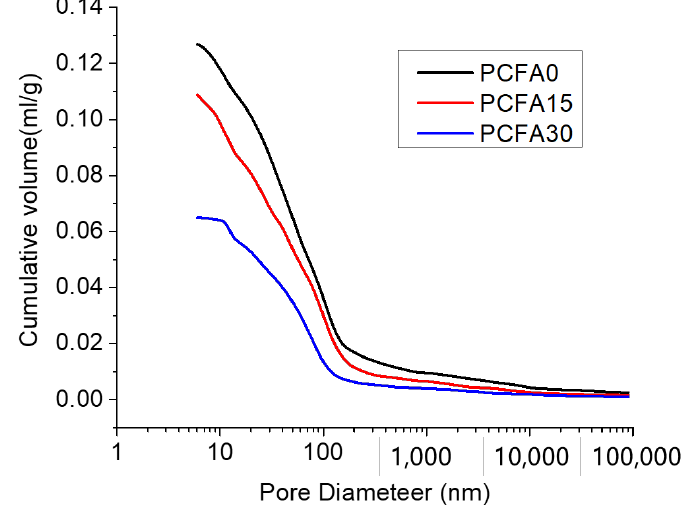
Figure 9. Cumulative porosity of concrete sample with different fly ash additions after 90 days of curing.